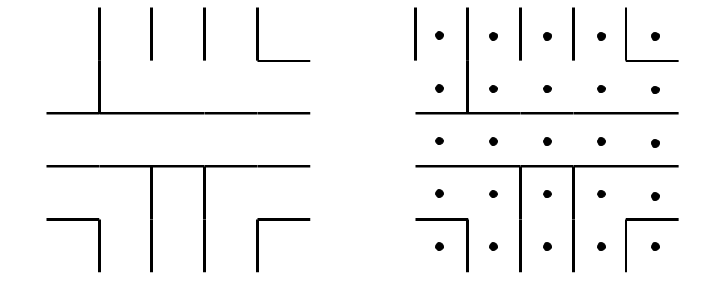
Figure 9 . Contrasting trivial centers: the left (cid:12)gure corresponds to the trivial center algebra of our model with square region of size n = 3, while the right (cid:12)gure corresponds to the trivial center algebra of Casini’s model [20] with square region of size n = 5. Only physical degrees of freedom have been left in both two (cid:12)gures. In the left (cid:12)gure, links mean both the corresponding operators ^ A and (cid:25) . In the right (cid:12)gure, links mean the corresponding electric (cid:12)elds and dots means the corresponding magnetic (cid:12)elds. We can see that the two trivial centers are quite di(cid:11)erent. The physical operators ^ A in the left (cid:12)gure can be got by truncating the magnetic (cid:12)elds in the right (cid:12)gure and then taking the maximum tree, which is a way to get the physical degrees of freedom and remove the redundancy. We will see it in (cid:12)gure 11 for details.